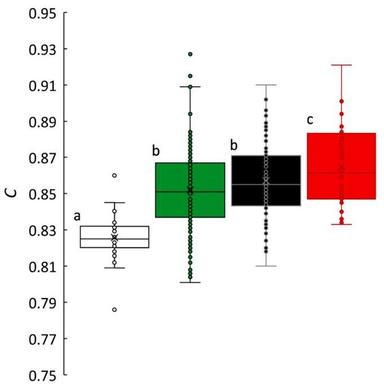
The egg circularity study results after synchronisation treatments. Distinct letters indicate significant differences analysed by ANOVA (p < 0.05). : Control; : L; : M; : H.